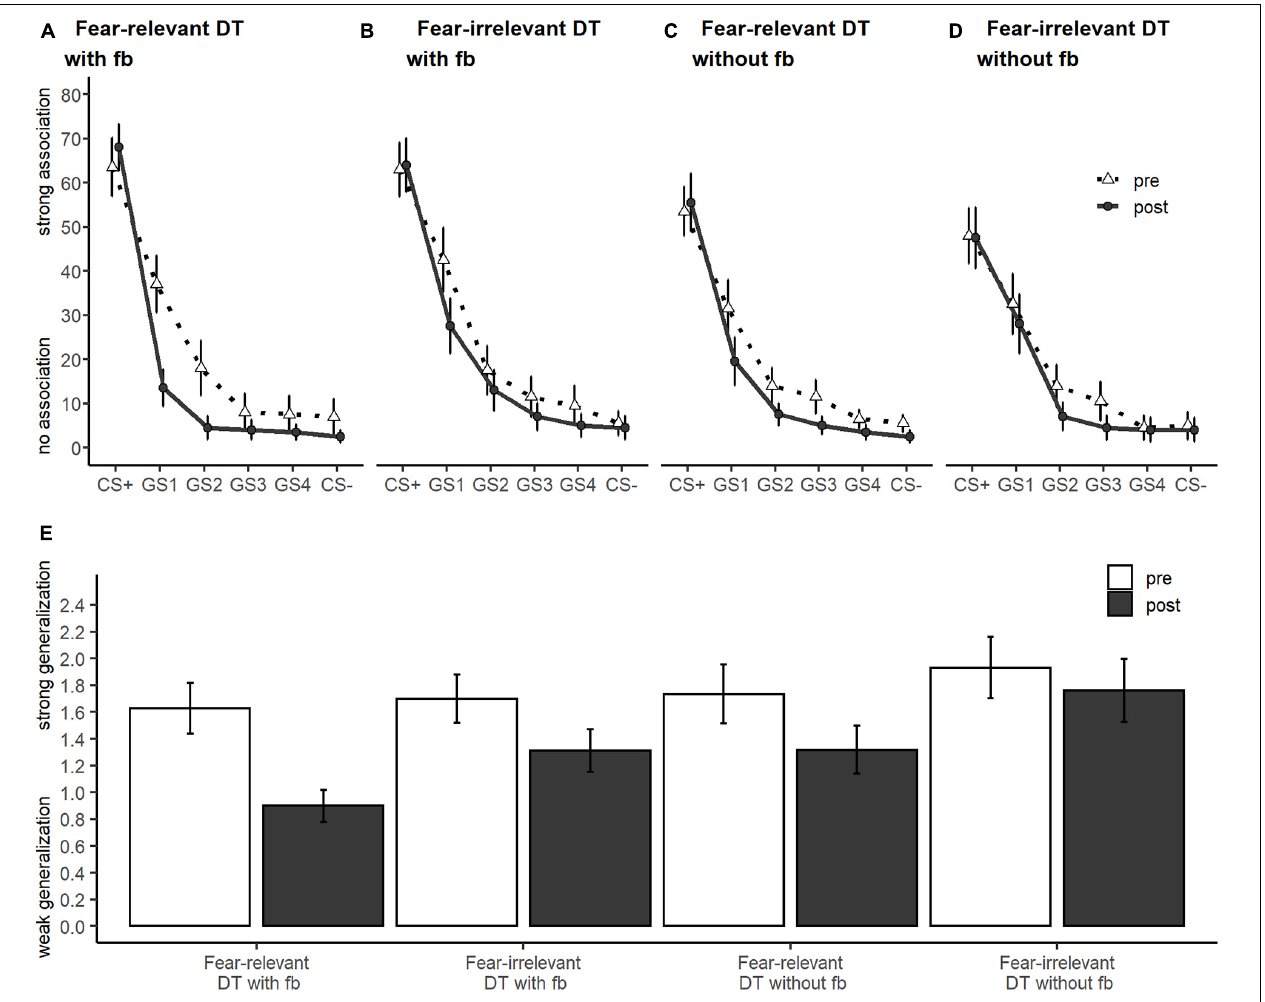
FIGURE 3 | Generalization gradients (A–D) and generalization indices (E) for unconditioned stimulus expectancy ratings separately for each training group and generalization pre- and